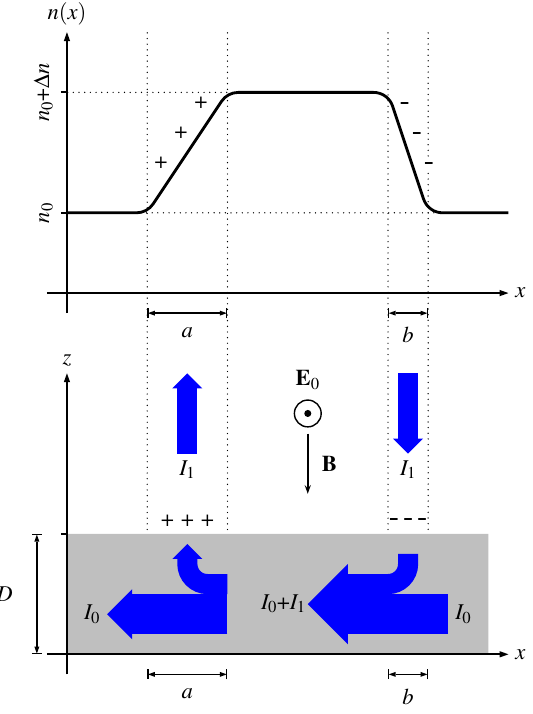
Figure 2. Illustration of a vertical cross-section through a magnetic flux tube with enhanced plasma density. At the top we show details of the geometry and density variations, while at the bottom of the figure we illustrate the currents generated by a steady-state electric field E 0 ⊥ B . The thickness of the E region is D ≈ 10–20km.